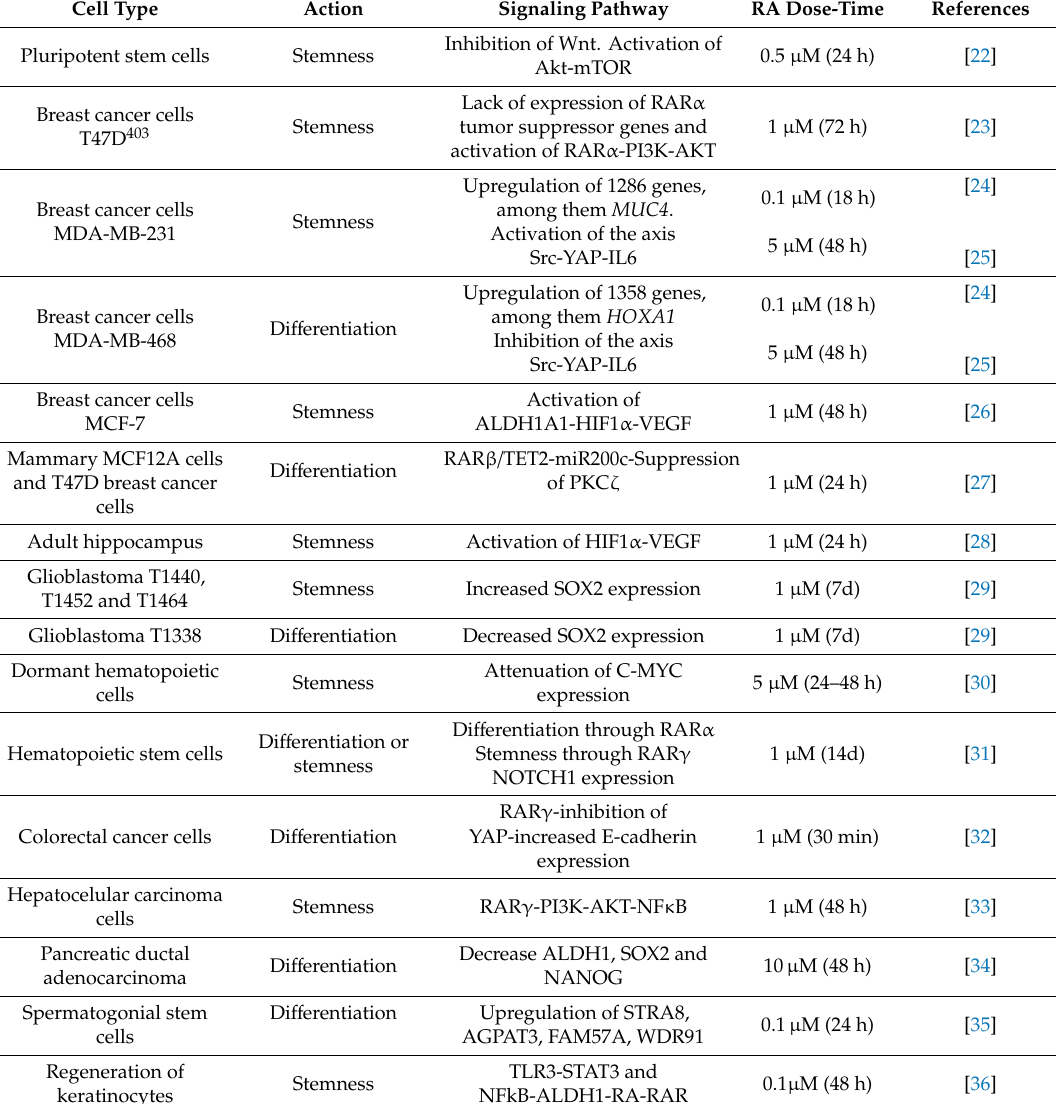
Table 1. Induction of stemness or cell di ff erentiation by retinoic acid (RA) in a cell-type-dependent